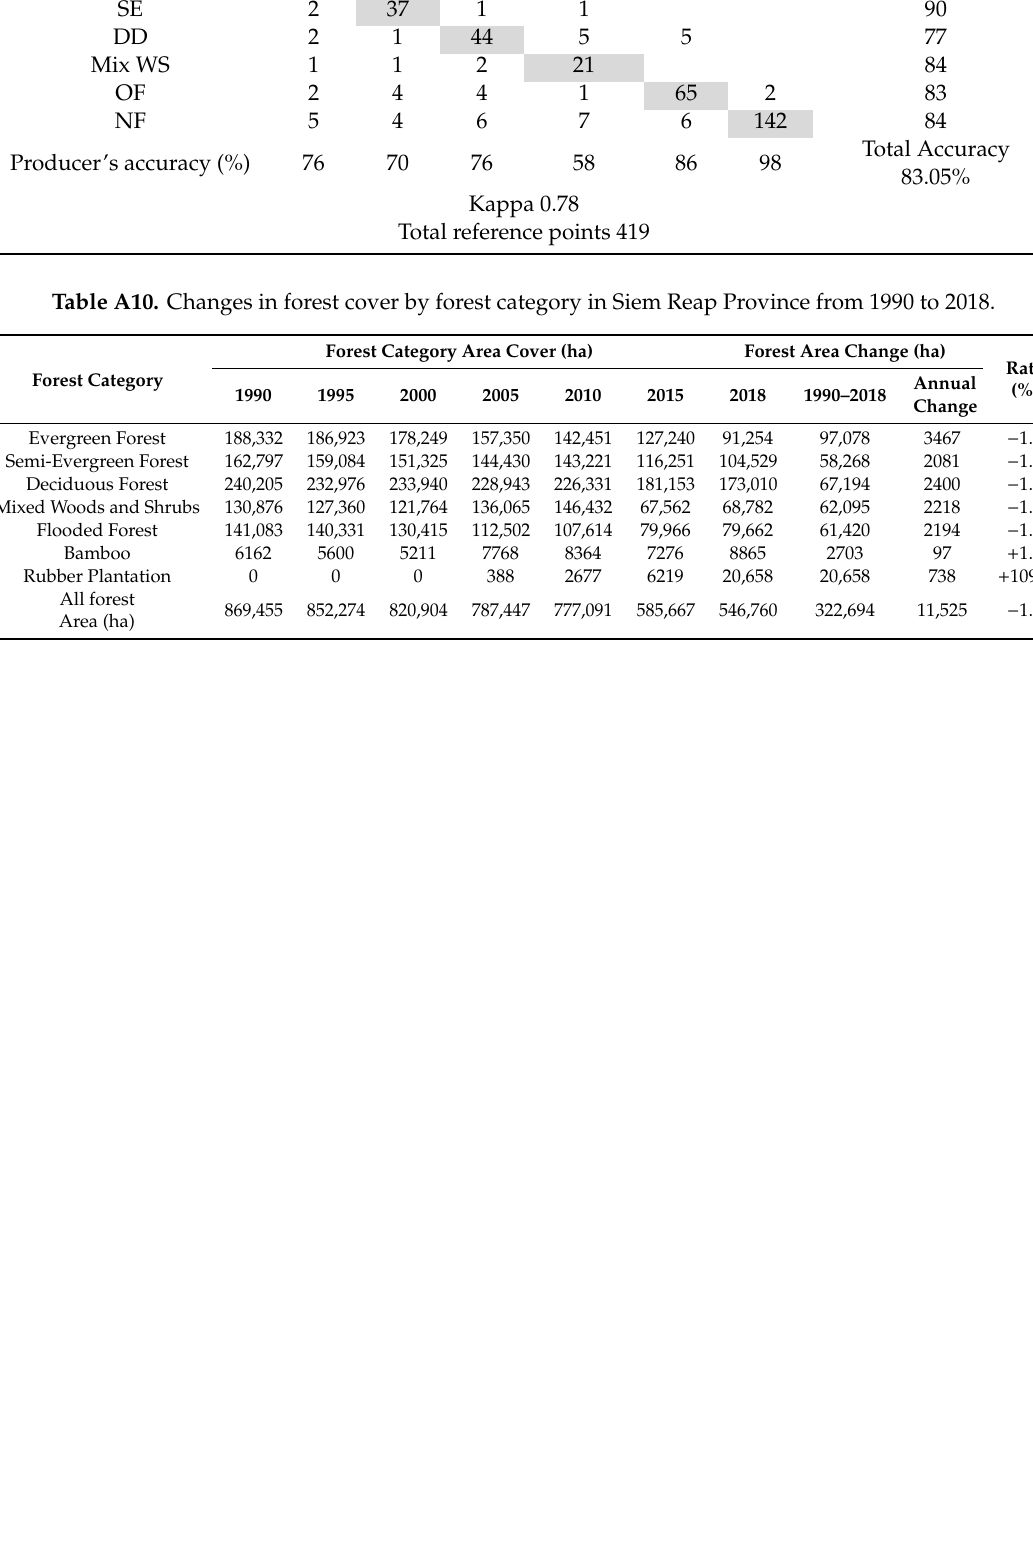
Table A9. Accuracy assessment of the PBTC land cover map and referenced land cover map for 2005. 2005 Ref LULC Category